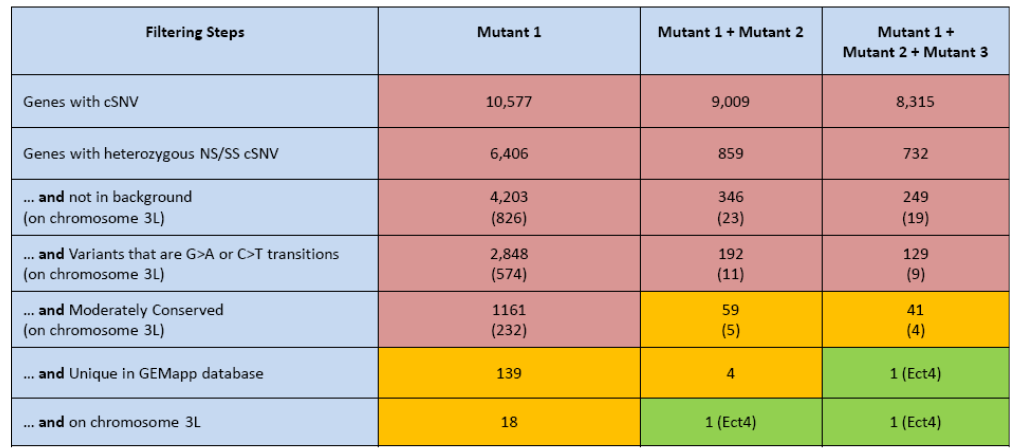
Figure 2. Filtering strategies used for gene identification by whole genome sequencing. Each box lists the number of genes with one or more protein-coding SNV (cSNV). Columns show the effect of requiring that one or more cSNV be observed in each of one to three mutant flies. Rows show the effect of filtering variants that meet certain analysis criteria. Row 6 displays the effect of including 8 samples from different screens in analysis.